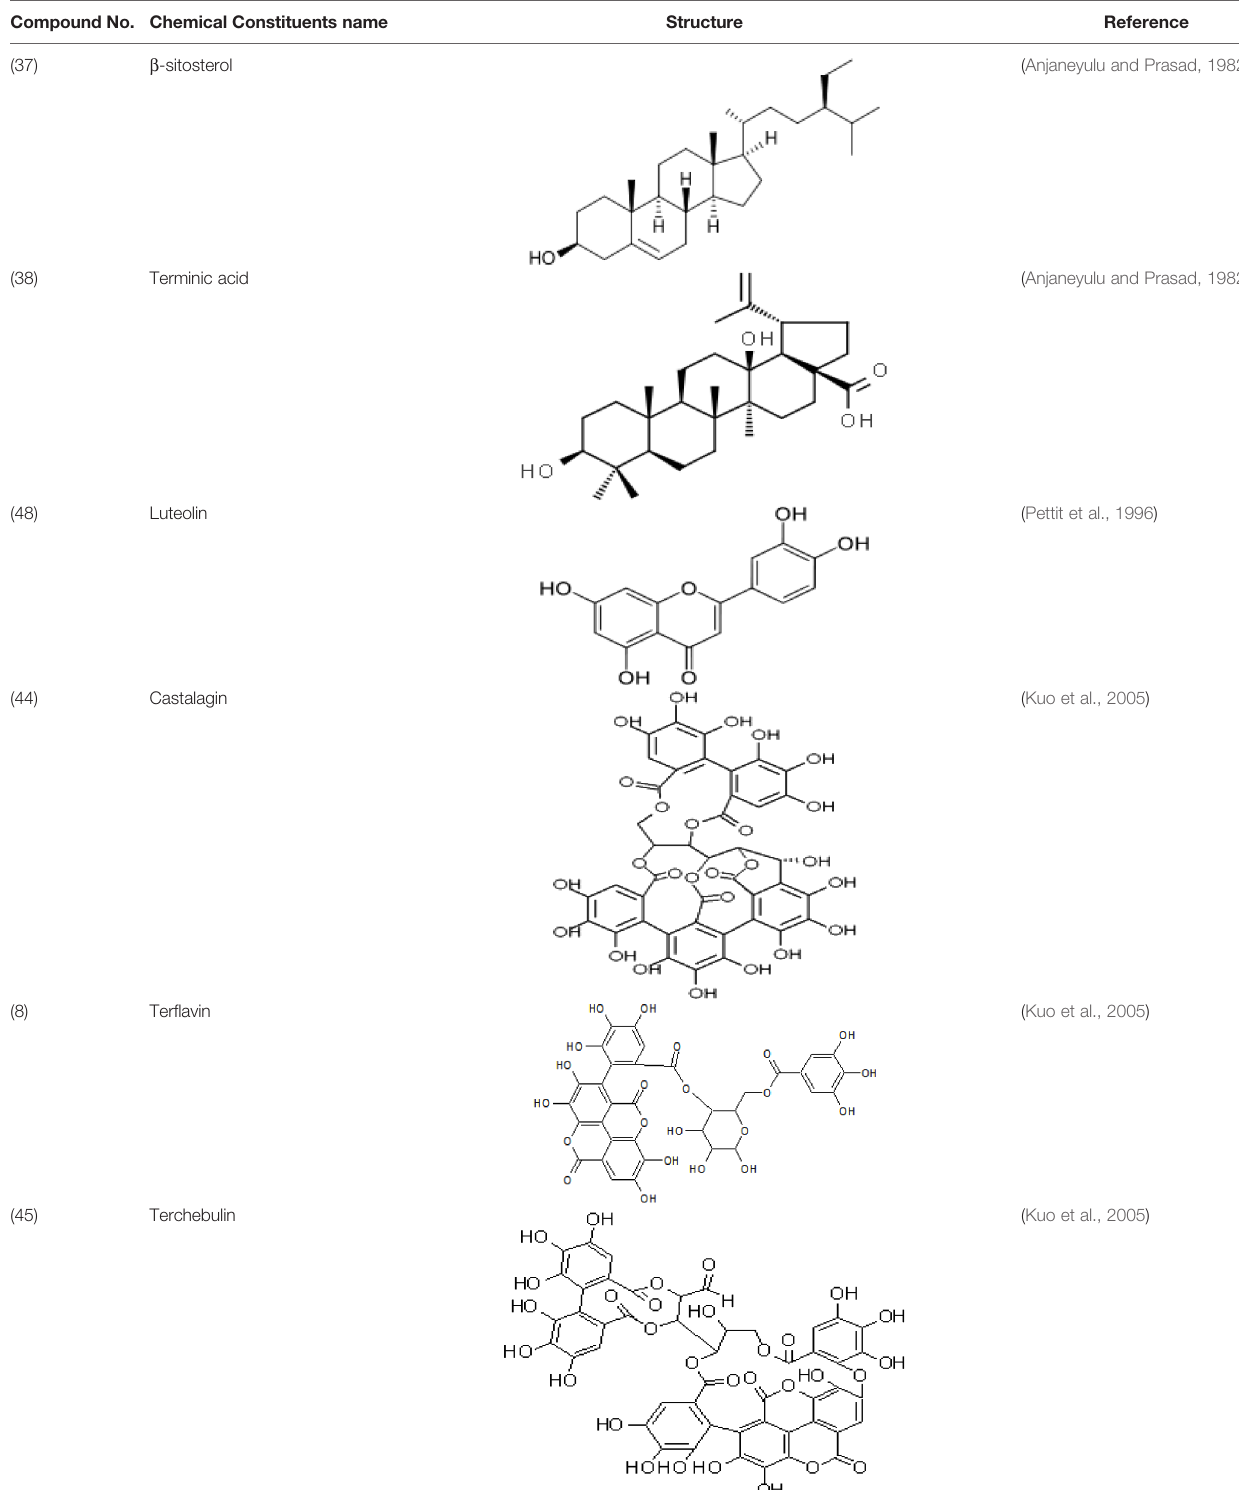
TABLE 1 | Chemical Constituents of T. arjuna (Roxb. ex DC.) Wight &